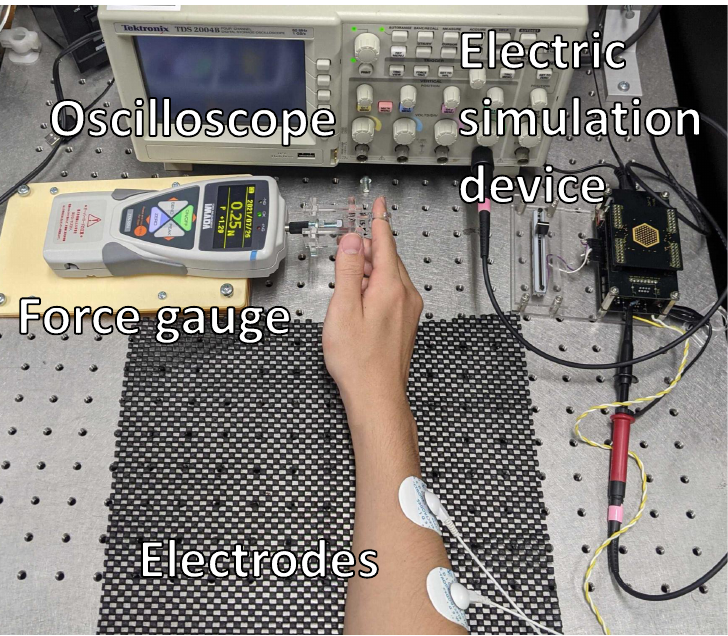
Figure 2. Overview of the voltage and presentation force measurement